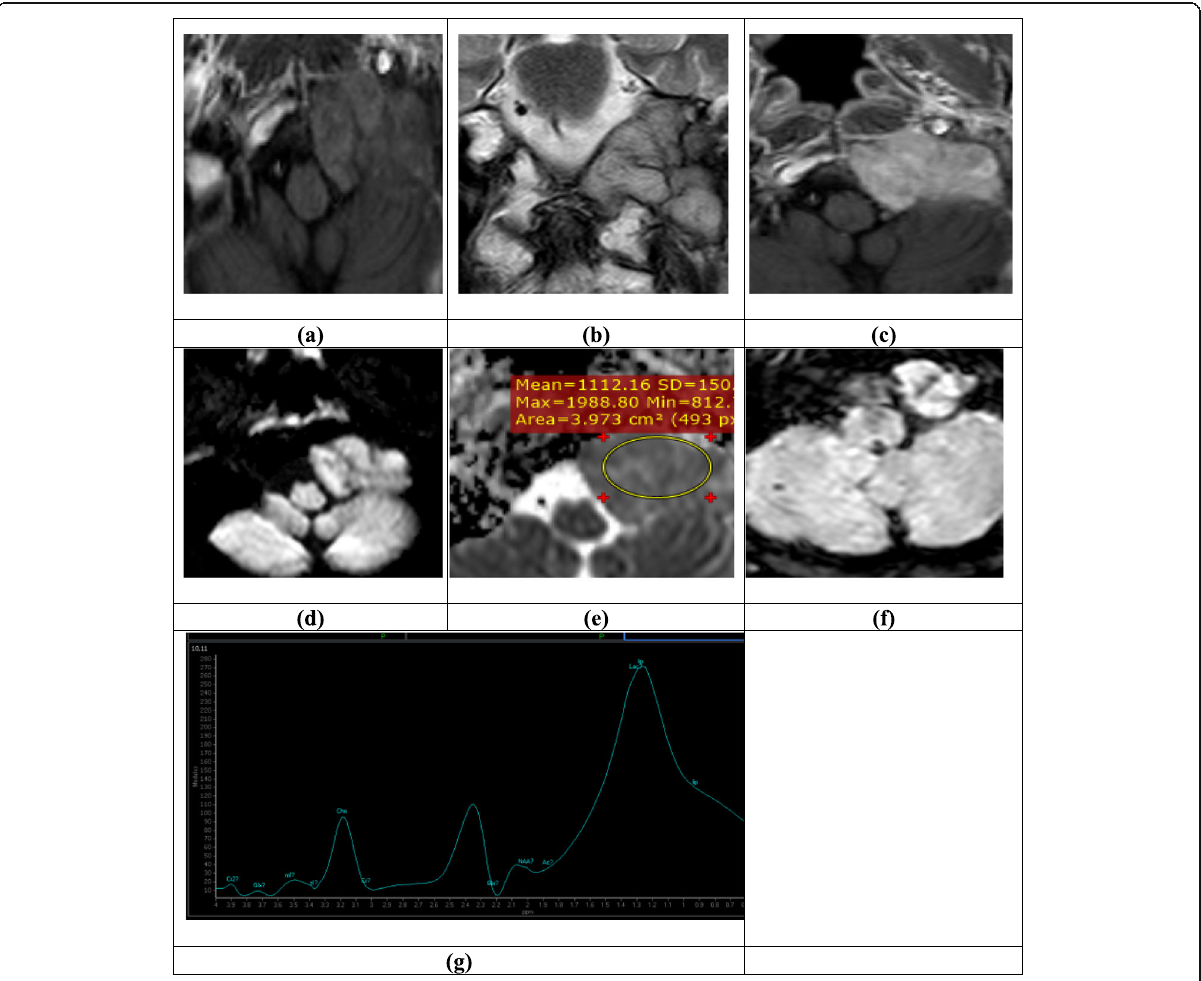
Fig. 7 A 38-years-old female with left pulsatile tinnitus. A left CPA mass is seen likely an extension from jugular foramen (widened and destroyed on CT). This is iso-intense on T1WI ( a ), hyperintense on T2WI and showing salt and pepper appearance ( b ), showing avid post-contrast enhancement on T1WI+C ( c ), hyperintensity on DWI with ADC value 1.1 × 10 − 3 mm 2 /s ( d , e ), foci of blooming on SWI ( f ) and high choline and lactate peaks on MRS ( g ). Conventional imaging findings are typical of the final post-excisional biopsy of the left glomus jugulare tumor. Additional imaging data of spectroscopy septra was